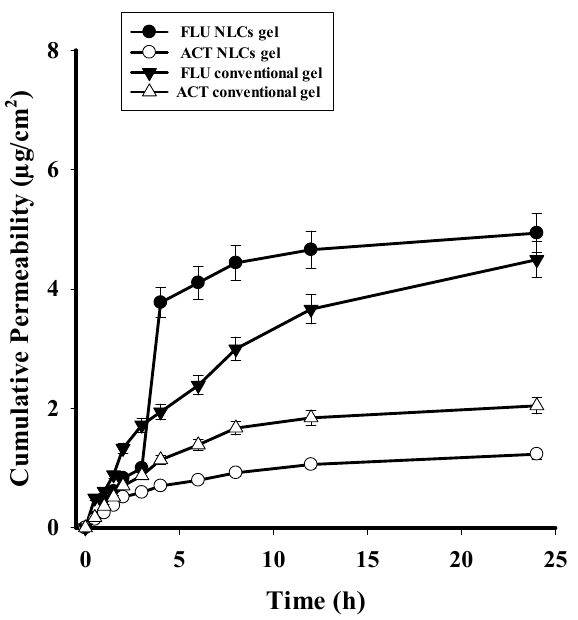
Figure 9. Ex vivo permeability data of FLU–ACT-coloaded NLC gel and FLU–ACT conventional gel.